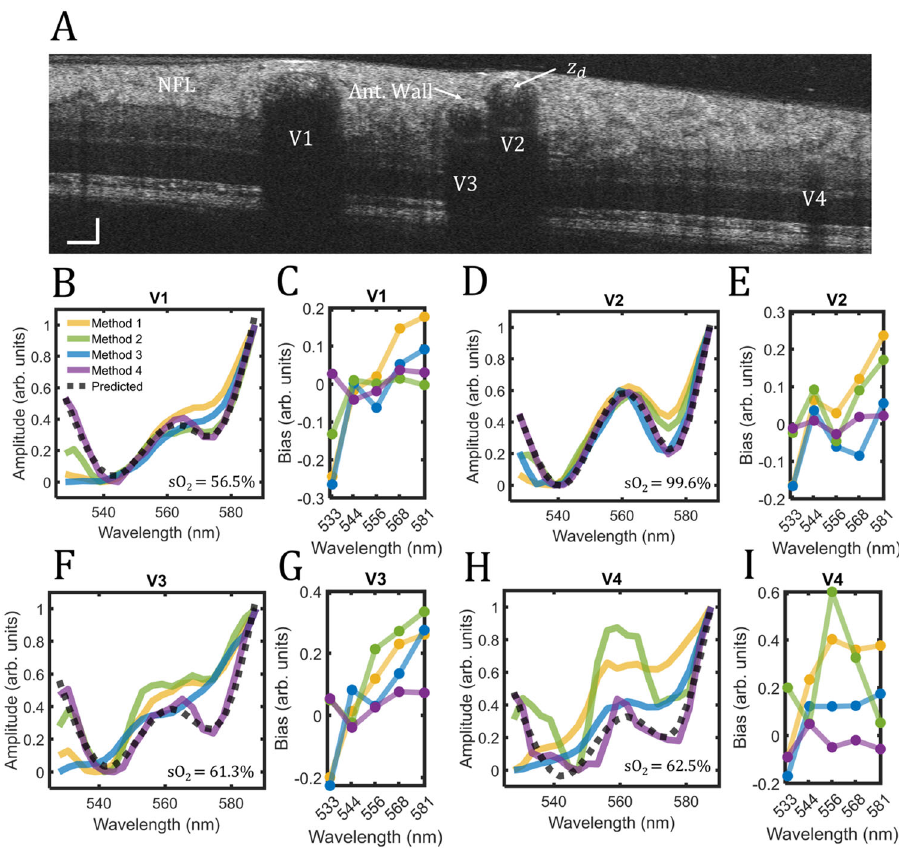
Fig. 3 Comparison of spectroscopic normalization methods. Spectroscopic normalizations in the human retina. A vis-OCT B-scan of a healthy human retina; vessels labeled V1-V4 were identi fi ed as vein, artery, vein, and vein, respectively; B Measured spectra in V1 with no normalization (yellow), normalization by NFL (green), normalization by the anterior vessel wall (blue), and normalization by the start of signal decay in the blood ( z d ) (purple), respectively; predicted spectrum for sO 2 = 56.5% (gray dashed line); C Bias for each normalization with respect to predicted spectrum at fi ve wavelengths; D , E Same analysis for V2 and sO 2 = 99.6%; F , G Same analysis for V3 and sO 2 = 61.3%; H , I Same analysis for V4 and sO 2 =